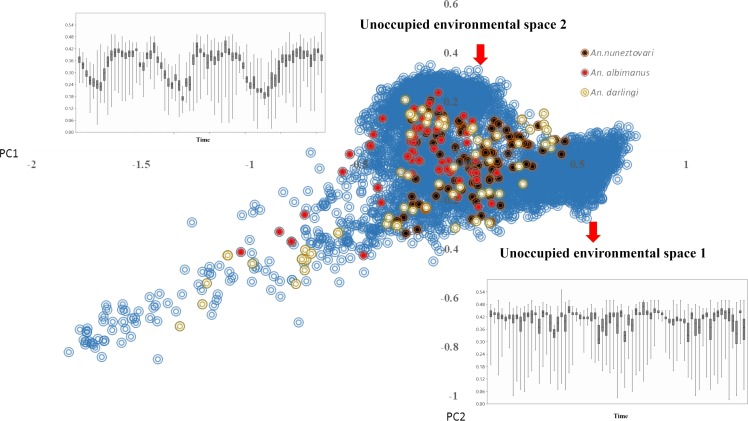
Results of the principal component analysis.Based on NDVI values for the Urabá-Bajo Cauca and Alto Sinú region of Colombia. Blue circles indicate NDVI values for sites across the study area. Other colored circles represent NDVI values for occurrence data for the main malaria vectors An. nuneztovari, An. albimanus, and An. darlingi. Red arrows indicate regions of available, but unoccupied environmental space. Box plots represent NDVI values in those unoccupied areas of environmental space (1 and 2).